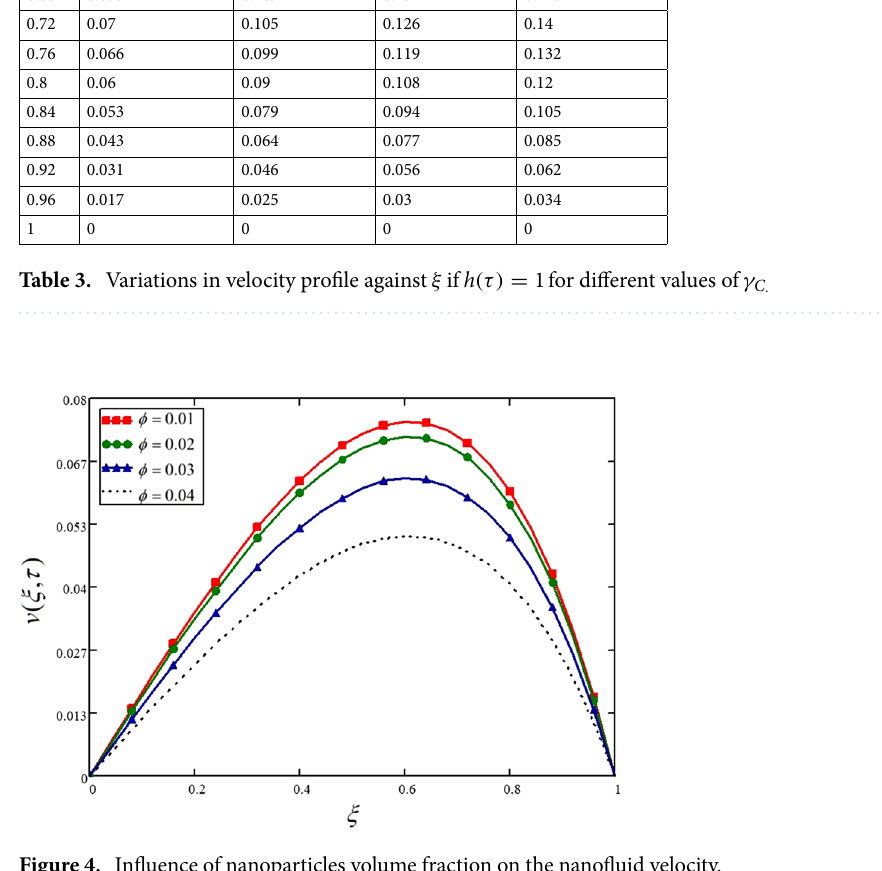
Figure 4. Influence of nanoparticles volume fraction on the nanofluid